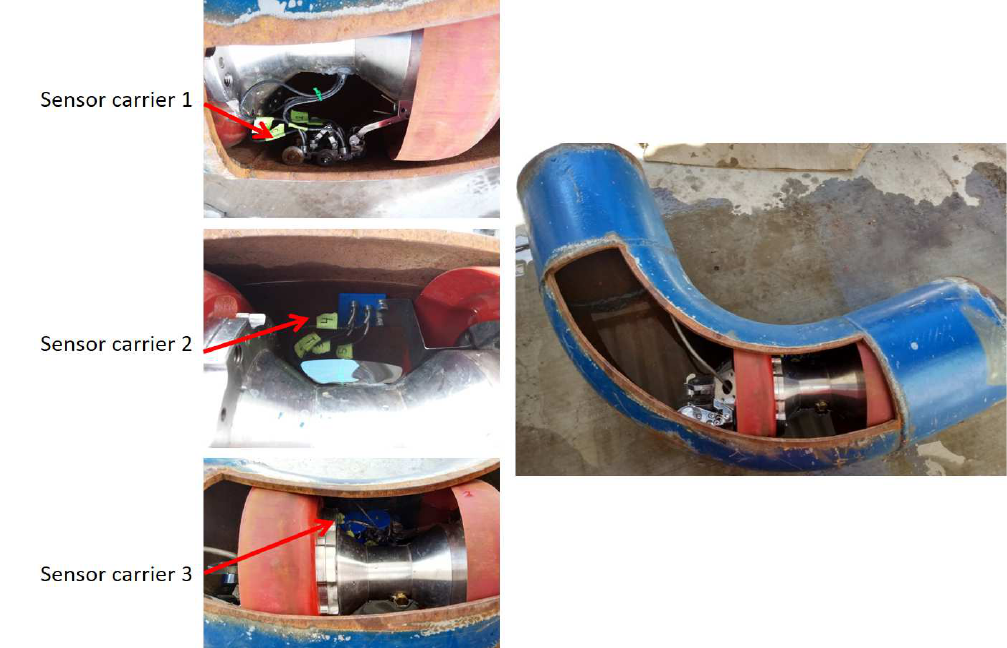
Figure 18. Experimental setup for concave and convex surfaces inspection with three different sensor carrier configurations.